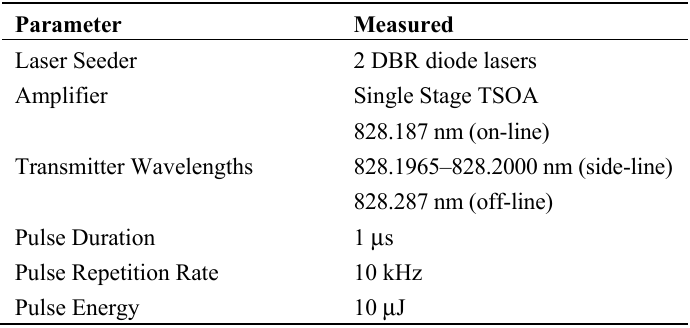
Table 1. A summary of the laser transmitter parameters. The short-term linewidth resulted from the heterodyne measurement, while the long-term bandwidth results from the resolution of the wavemeter used to lock the on-line seed